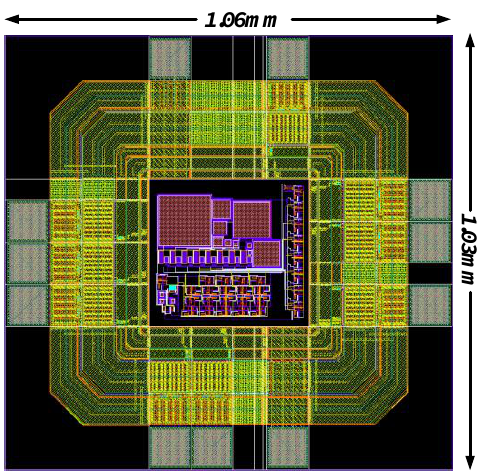
Figure 38. The layout design with padding.